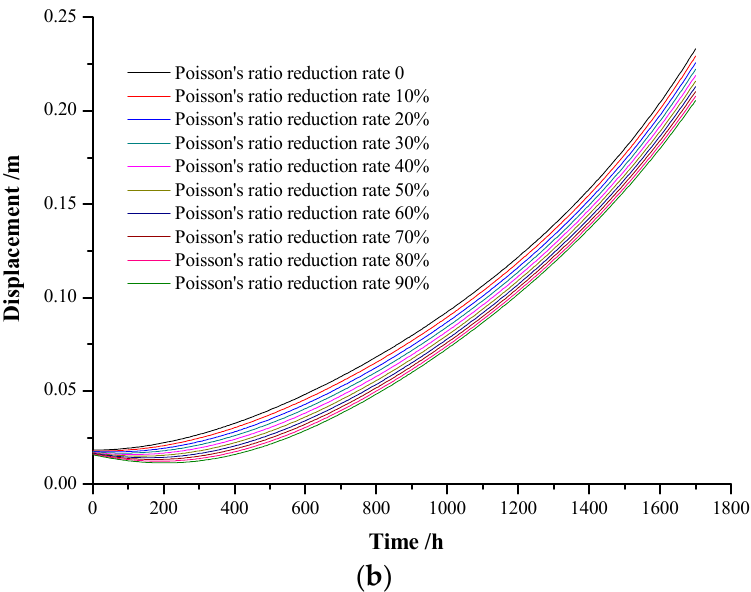
Figure 8. Variation of perimeter displacement with Poisson’s ratio. ( a ) D3 monitoring point. ( b ) D6 monitoring point.